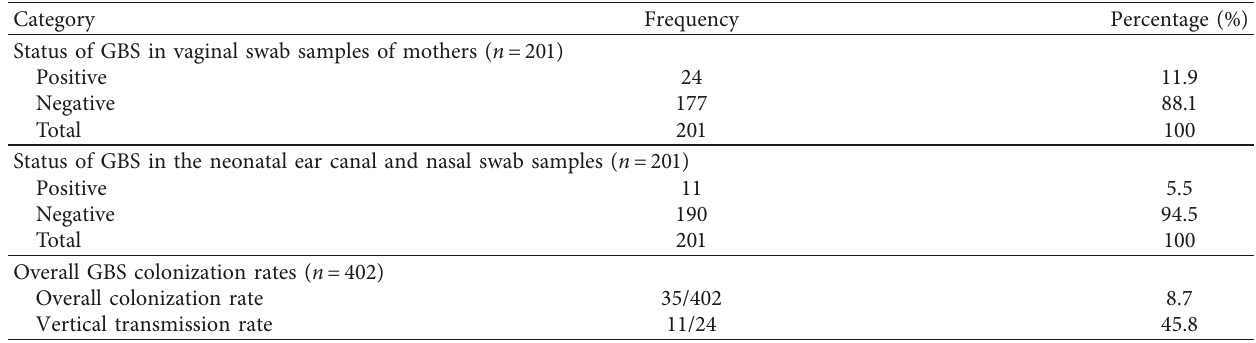
Table 2: Status of GBS in mothers and neonatal body site swab